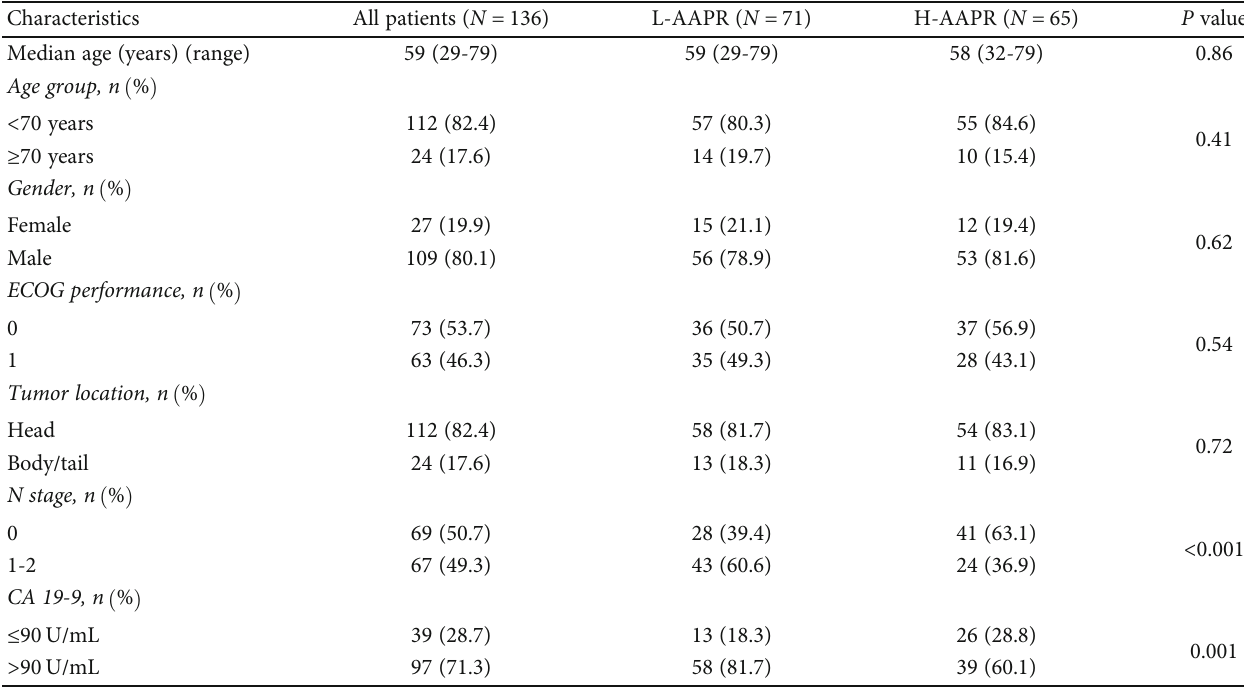
Table 1: Baseline patient and disease characteristics for the entire study group and per low and high albumin-to-alkaline phosphatase ratio